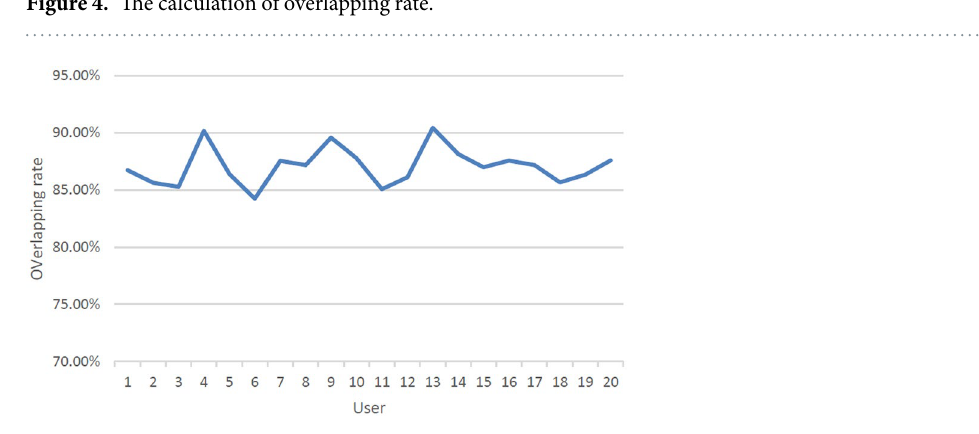
Figure 4. The calculation of overlapping rate.